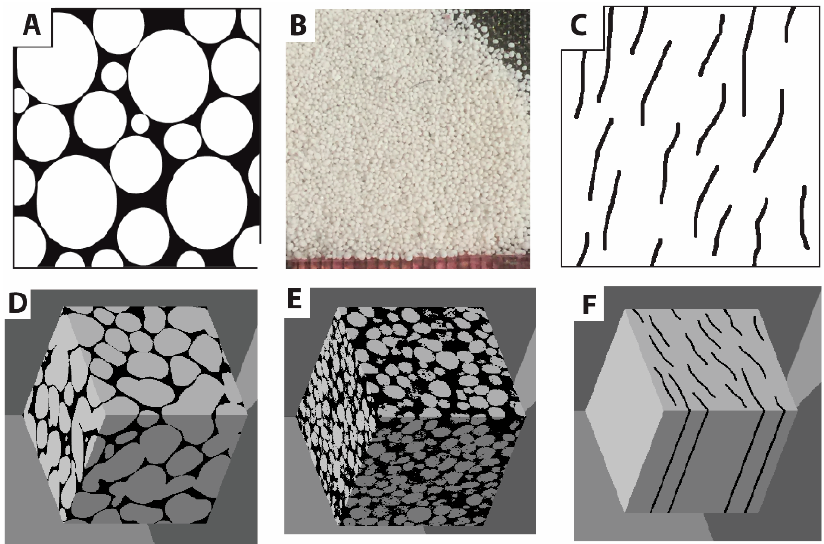
Figure 1. Examples of materials used to construct base images: ( A ) Binary 2D cartoon of nominal oolitic limestone structure, ( B ) loose grains of Bahamian ooids (ruler along base graduated in mm), ( C ) binary 2D cartoon of idealized simple fracture system. Additionally, ( D – F ) binary 3D models of solid (grey) versus pore / fracture (black), developed from ( A – C ), respectively. Note ( D ) and ( E ) represent the base models of oolitic limestone architecture prior to modification, and ( F ) is the base fracture network that was utilized to superimpose on ( D ) and ( E ) after the addition of cement. Scales in ( A ), ( C ) was 400 pixels × 400 pixels and in ( D – F ) was 400 voxels × 400 voxels × 400 voxels.